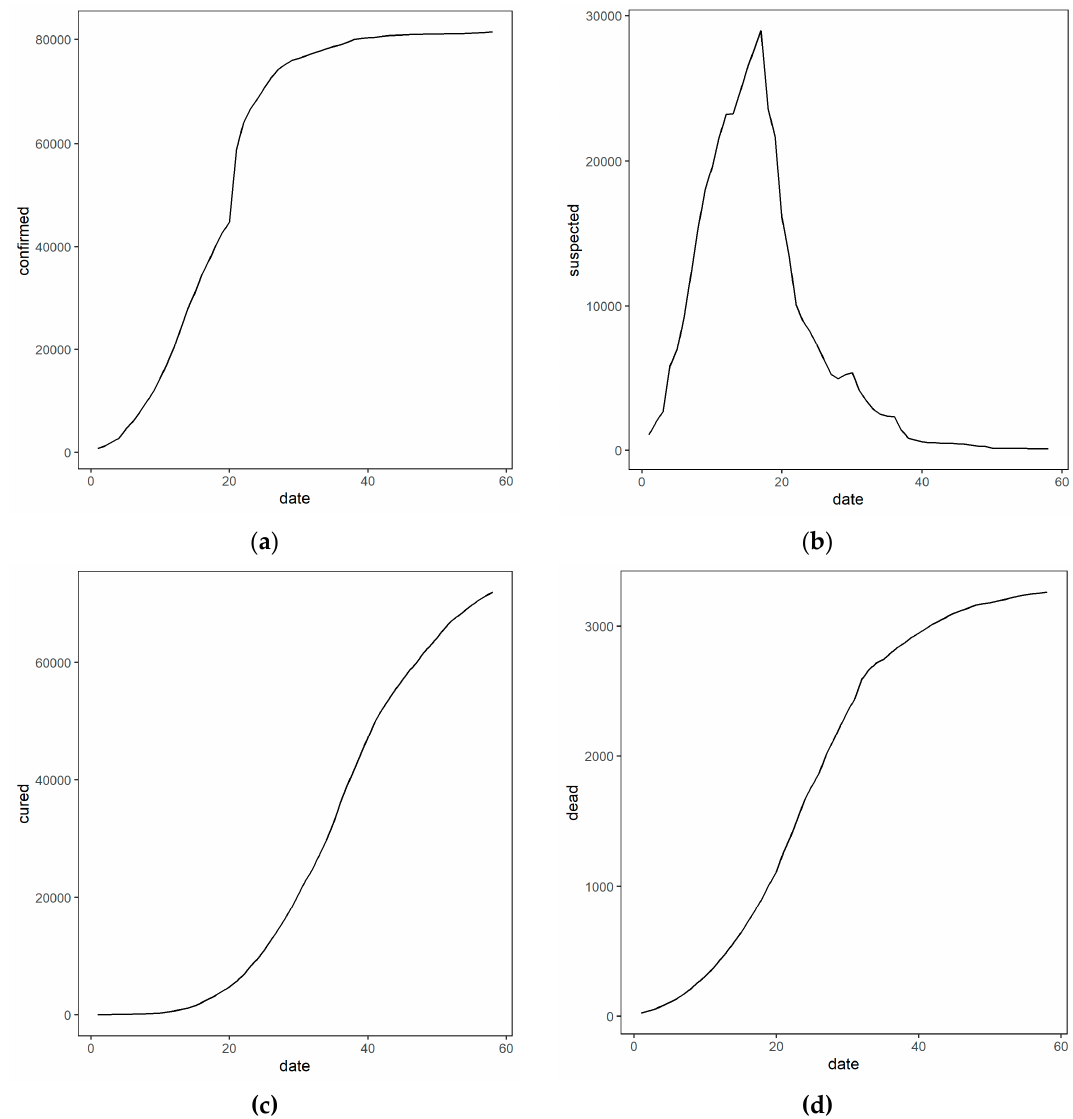
Figure 1. The national epidemic trend of the COVID-19 in China from January 23 to March 20, 2020.